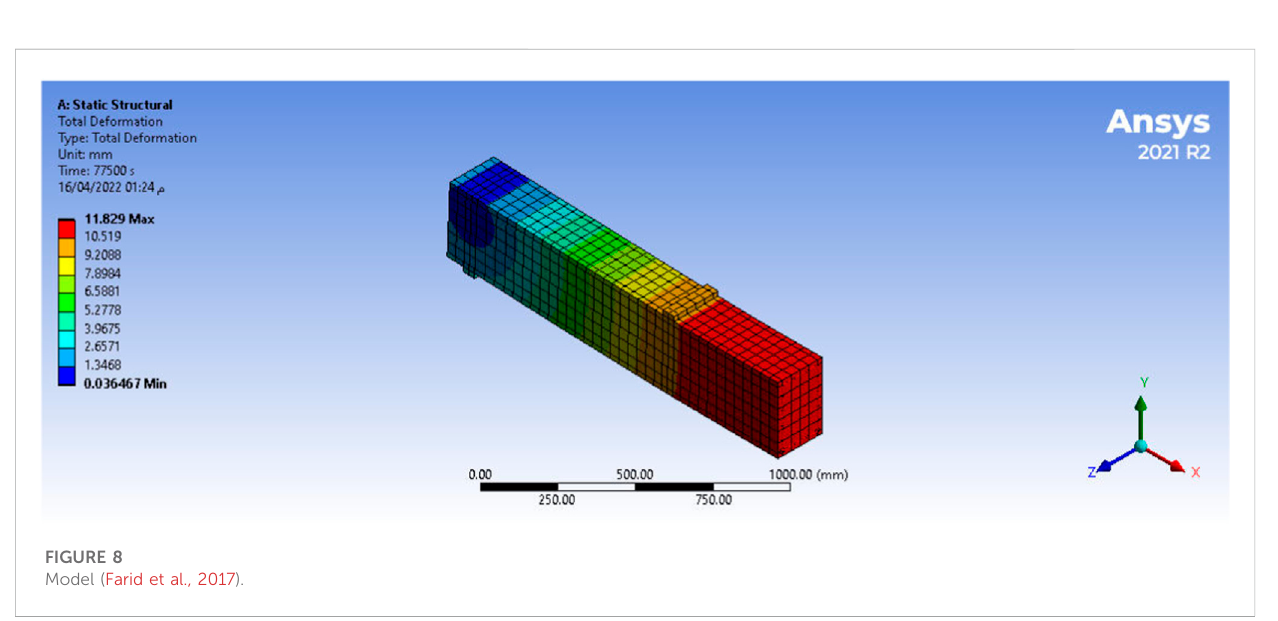
Model (Farid et al.,